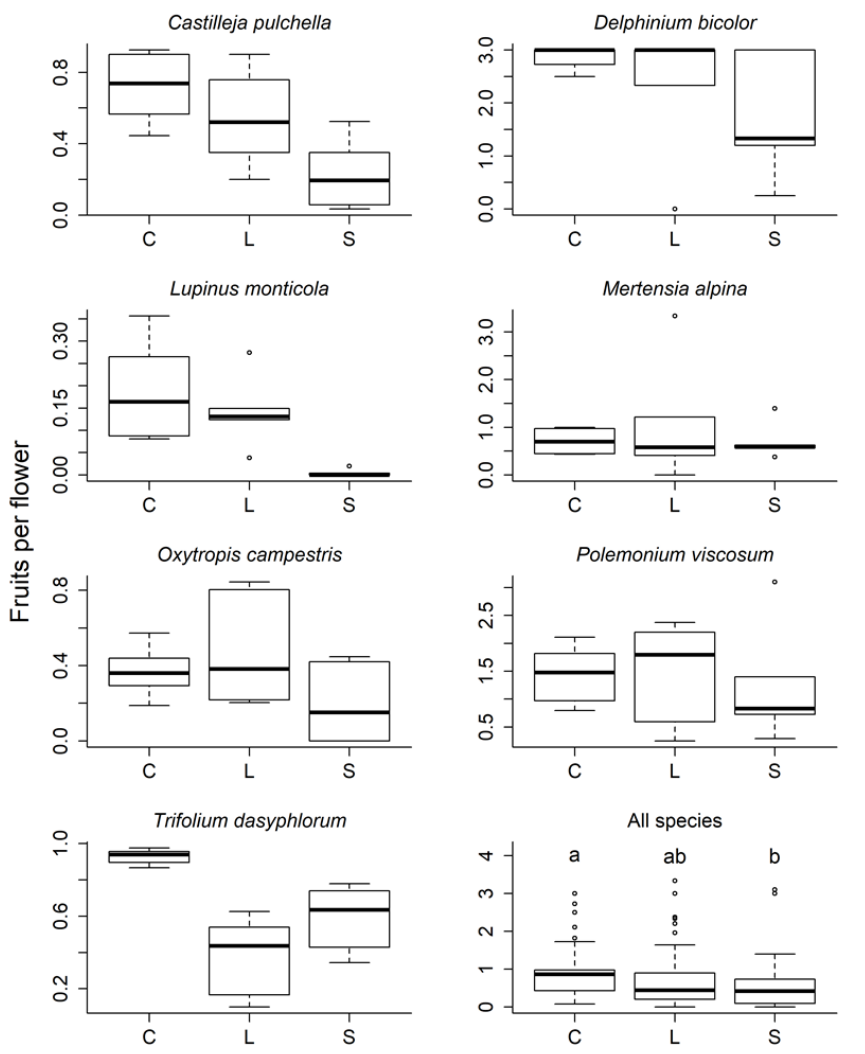
Figure 5. Fruits per flower by exclosure treatment. C = Control, L = Large wire mesh, S = fine screen door mesh. Widened central lines in boxes are medians. Hinges are quartiles. Whiskers extend to the most extreme data point that is no more than 1.5 times the length of the box away from the box. Lower right plot indicates differences between exclosure types for all species. Box plots with the same letter code indicates no significant difference in fruit set after controlling for FWER using Tukey’s